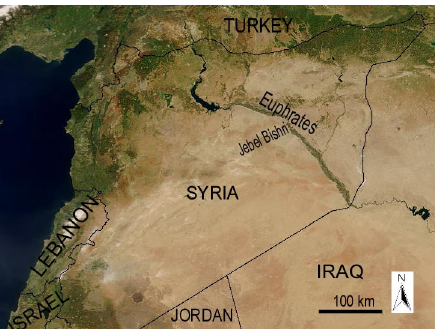
Figure 1. The location of Jebel Bishri, a mountain in Central Syria along the Euphrates, on a satellite image. Mapping by M. Lönnqvist